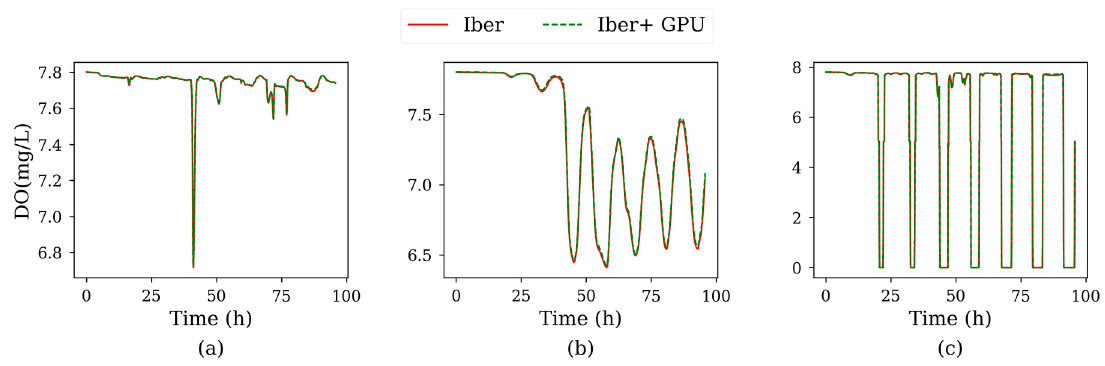
Figure 8. Time series of DO for Test 2 at control points P1 ( a ), P2 ( b ) and 3 ( c ).